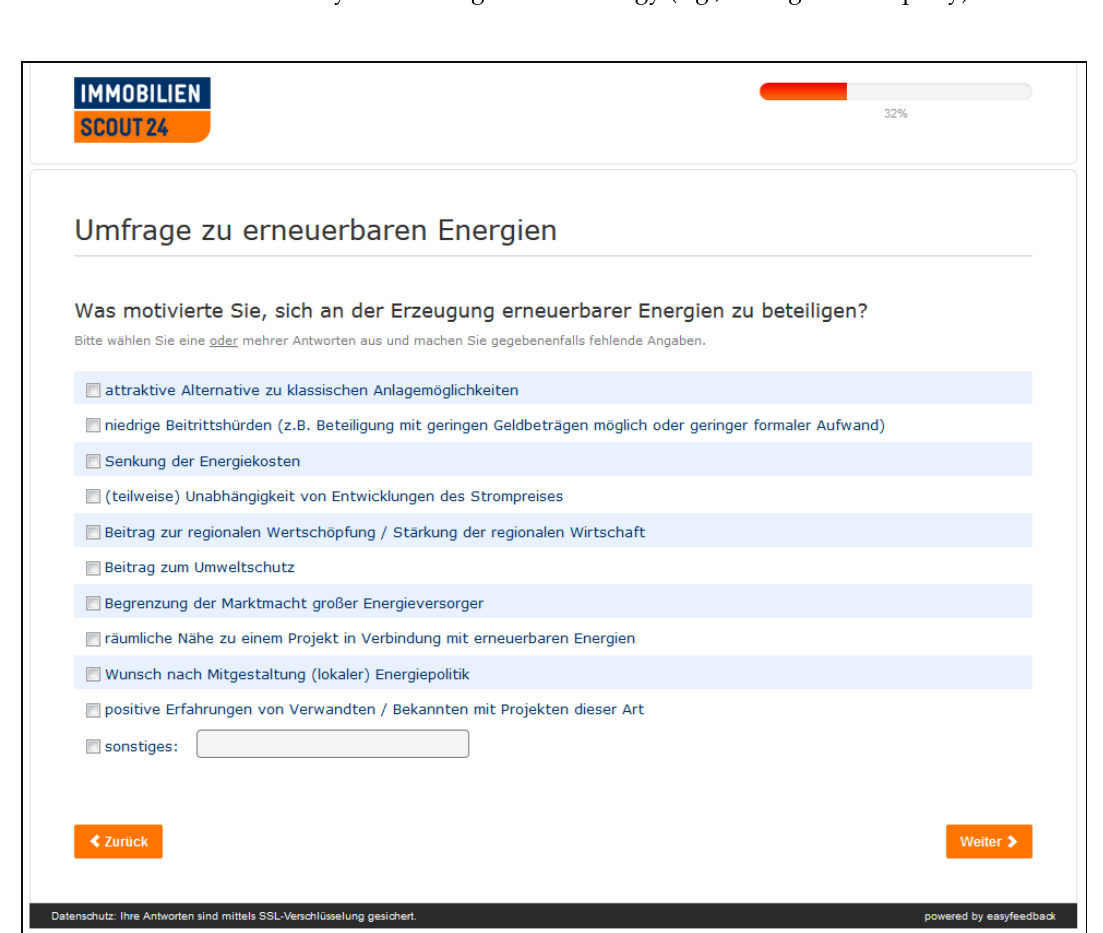
Figure A8. Screenshot of Questionnaire Page 7.